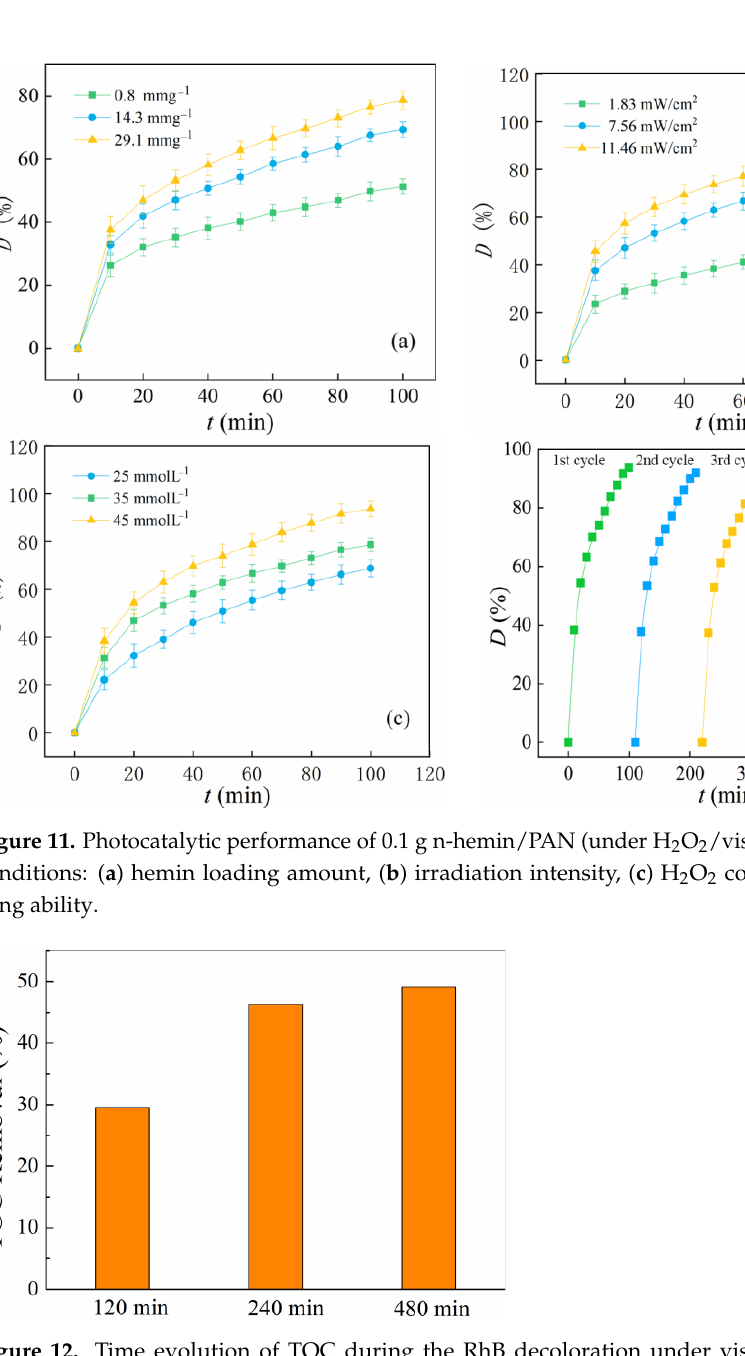
Figure 12. Time evolution of TOC during the RhB decoloration under visible light irradiation with H 2 O 2.